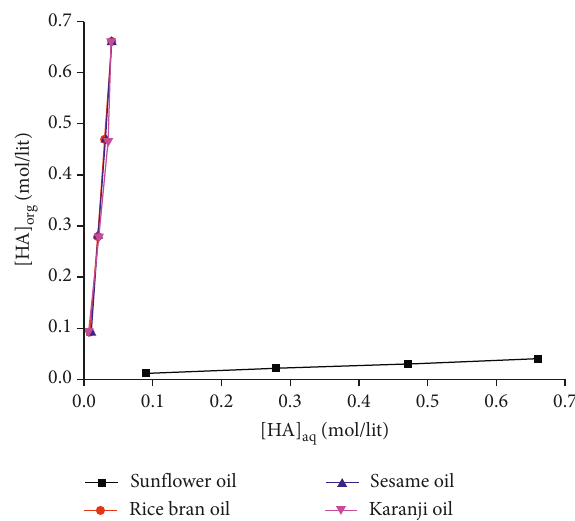
Figure 2: Reactive extraction equilibria for succinic acid using 20%